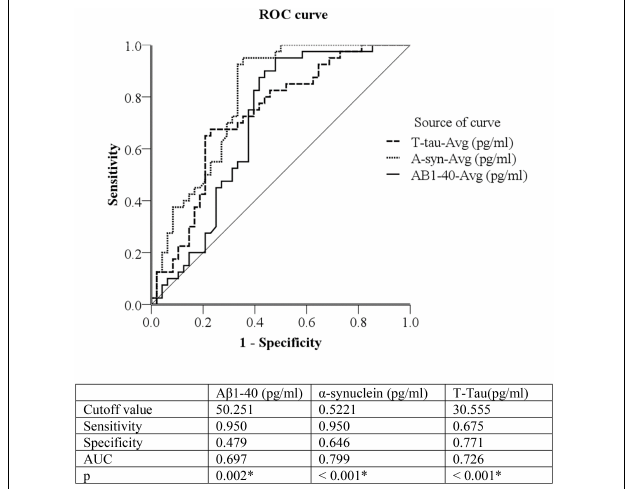
FIGURE 1 | Discrimination of Normal Cognitive function versus PD patients with cognitive impairment by 3 plasma biomarkers: plasma A β -40, α -synuclein, and T-Tau (pg/ml). Due to A β 1-40 being higher in normal controls, we used 1/A β 1-40 to draw the ROC curve. A β 1-40 (pg/ml) cutoff value = 50.251, inverted A β 1-40 (pg/ml) = 0.0199 ROC curve = Receiver operating characteristic curve, PD = Parkinson disease PD patients with cognitive impairment = Mini-Mental State Examination (cid:53)